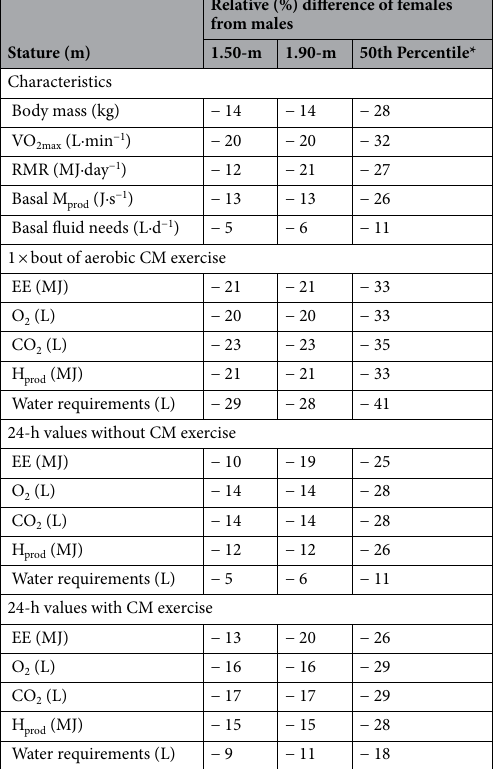
Table 5. Relative (%) difference between the theoretical female and male astronaut populations (see 9 ) at the lower (1.50-m) and upper (1.90-m) ends of the stature comparison range, and at the 50th percentile for stature for United States females (1.615-m) and males (1.757-m). VO 2max maximal rate of oxygen uptake, RMR resting metabolic rate, M prod metabolic heat production, EE energy expenditure, O 2 total oxygen consumed, CO 2 total carbon dioxide produced, H prod total metabolic heat produced. *For United States (US) females (1.615-m) and males (1.757-m) based on the US Centre for Disease Control (CDC) 2015–2016 National Health and Nutrition Examination Survey (NHANES) 28